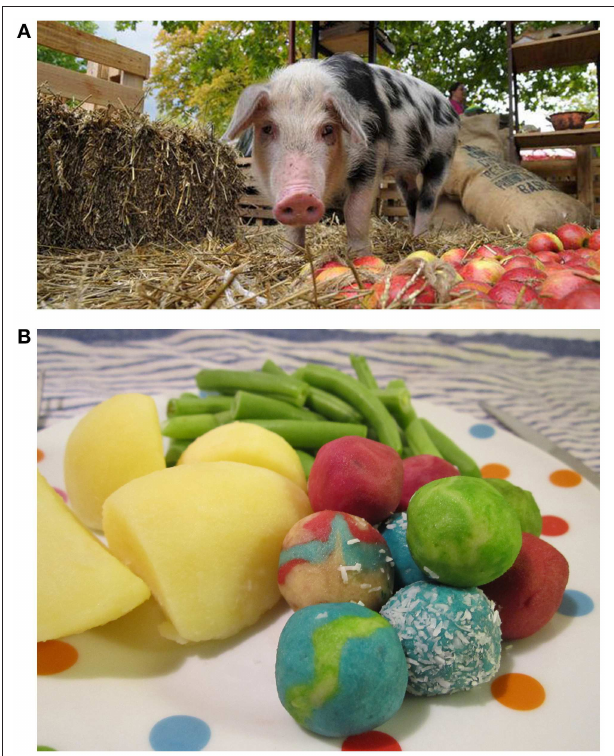
FIGURE 1 | Two of the four visual scenario’s. (A) “The pig in the backyard”, Courtesy to PeerGrouP and Rotterdamse Oogst. (B) Magic meat, designed by Mark Kanters as part of Koert van Mensvoort’s Next Nature course (Photograph: Cor van der